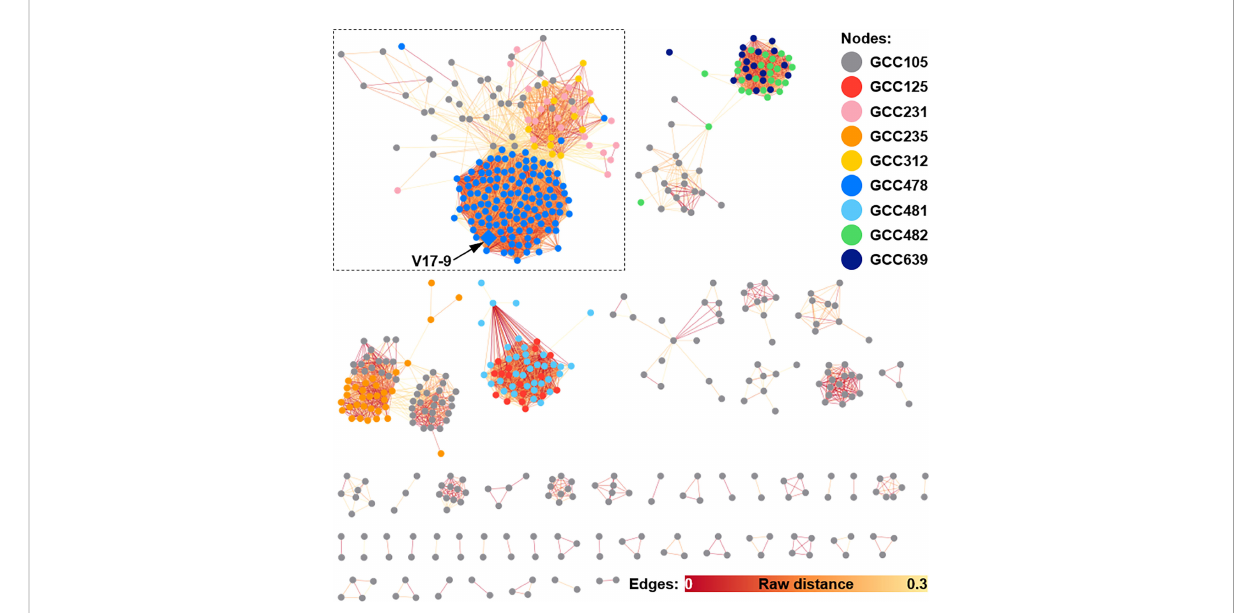
FIGURE 4 Sequence similarity network of indole BGCs generated by BiG-SCAPE. A total of 578 indole BGCs, excluding 79 singletons, from 2,062 Streptomyces genomes are shown as a similarity network. Nodes are fi lled with the nine different colors by the gene family clans (GCCs) they belong to. Edges are shown in the color gradient denoting the raw distance retrieved from the BiG-SCAPE analysis. The largest component is highlighted with a dashed box. The BGC identi fi ed from the V17-9 is shown as a diamond and indicated by an arrow. BGCs, biosynthetic gene